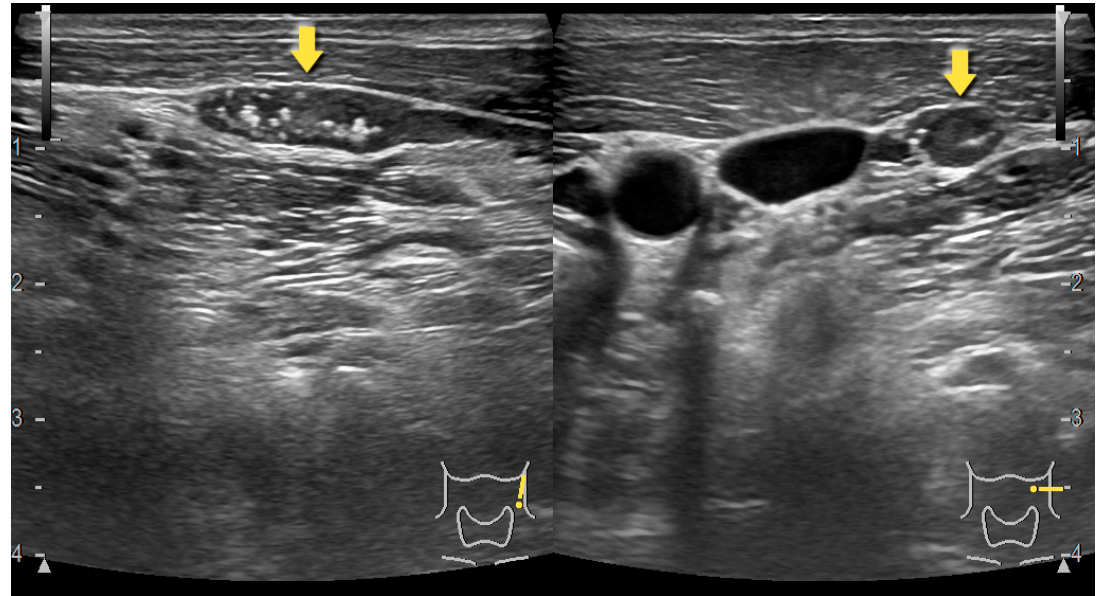
Figure 1. Parathyroid adenoma detected by USG.